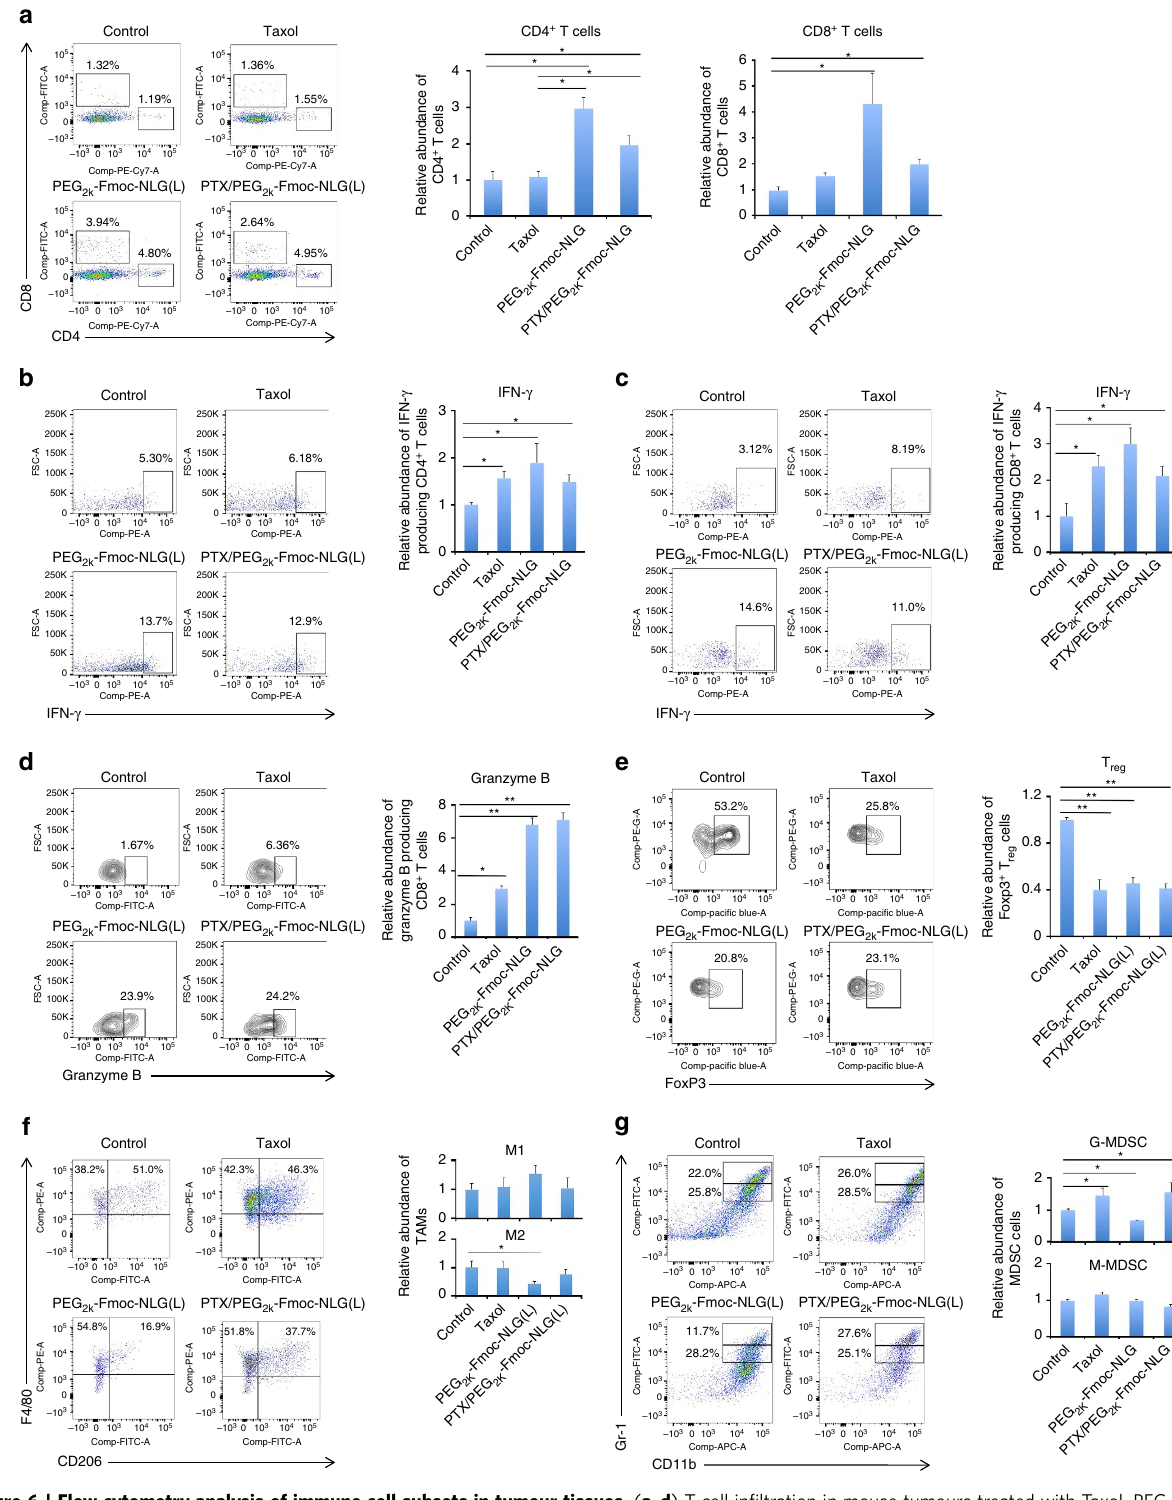
NATURE COMMUNICATIONS|7:13443|DOI: